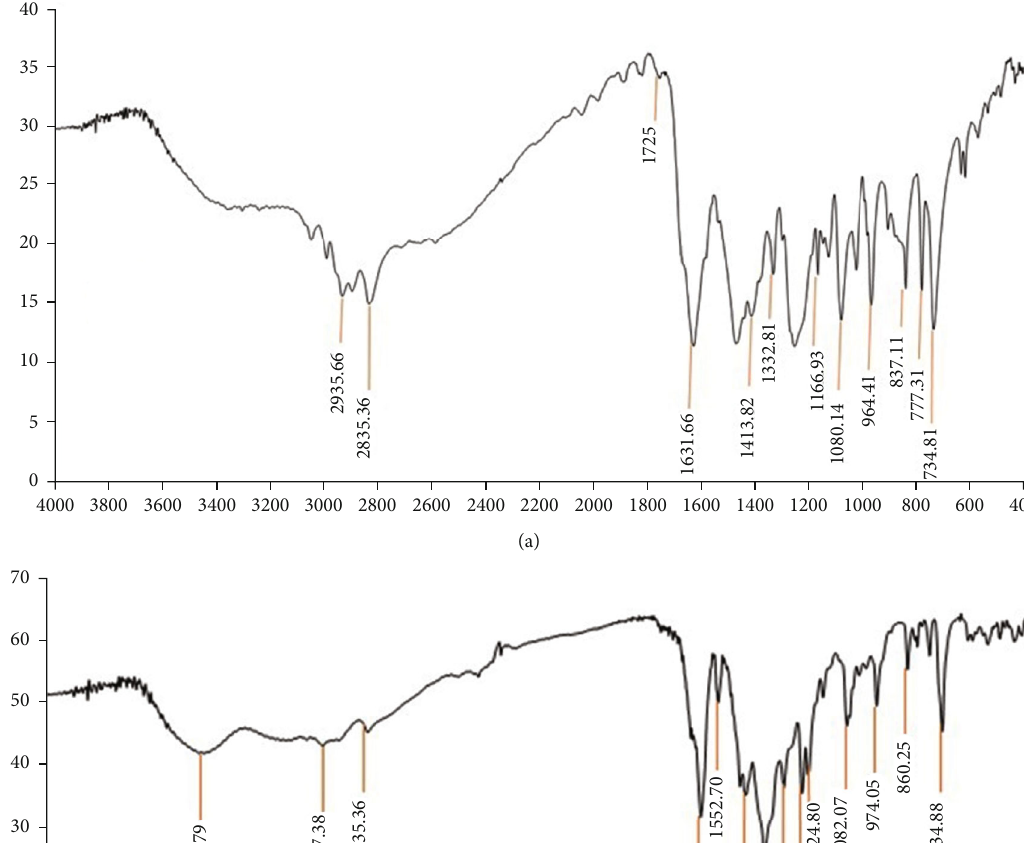
Figure 9: FTIR spectra of (a) H